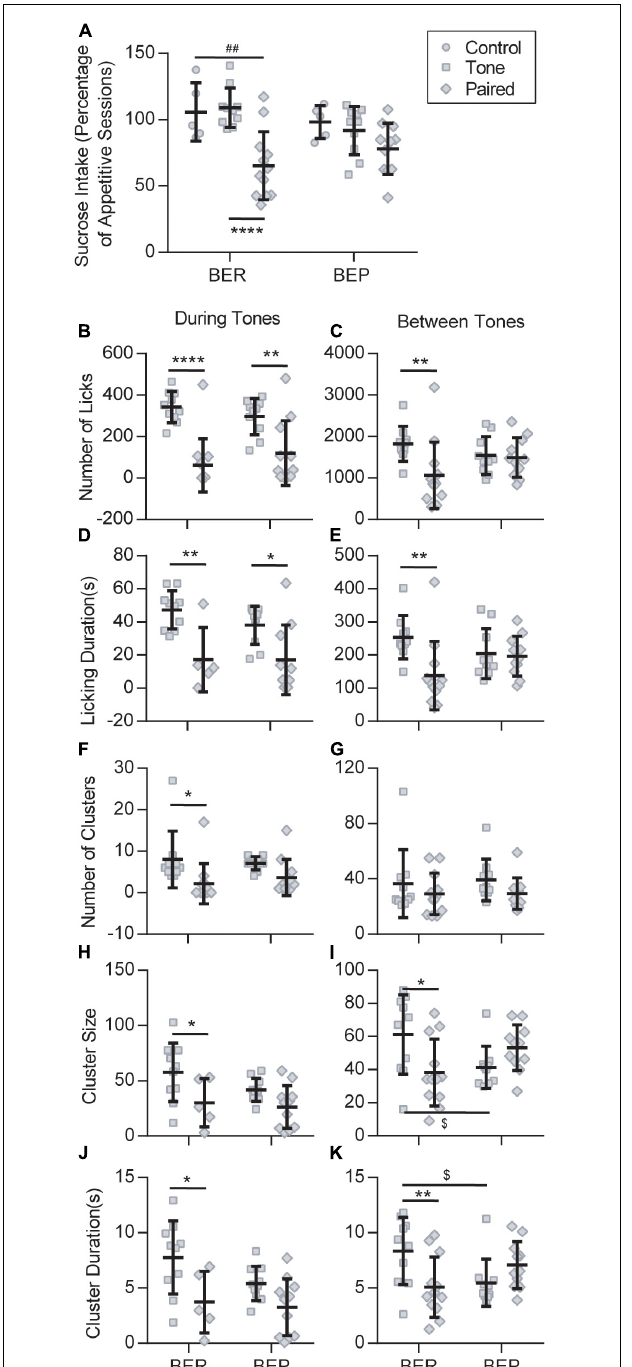
FIGURE 3 | Feeding behavior during the Test session. (A) Sucrose intake during the Test session normalized to the average intake of each animal during all appetitive sessions. ## Significantly different ( p < 0.01) from the BER-Control group. ****Significantly different ( p < 0.0001) from the BER-Tone group. Licking microstructures during the Test session: number of licks (B,C) , licking duration (D,E) , number of clusters (F,G) , cluster size (H,I) , and cluster duration (J,K) . *Significantly different ( p < 0.05) from the Tone group with the same phenotype. ** p < 0.01, **** p < 0.0001. $ Significantly different ( p < 0.05) from the BER-Tone group.